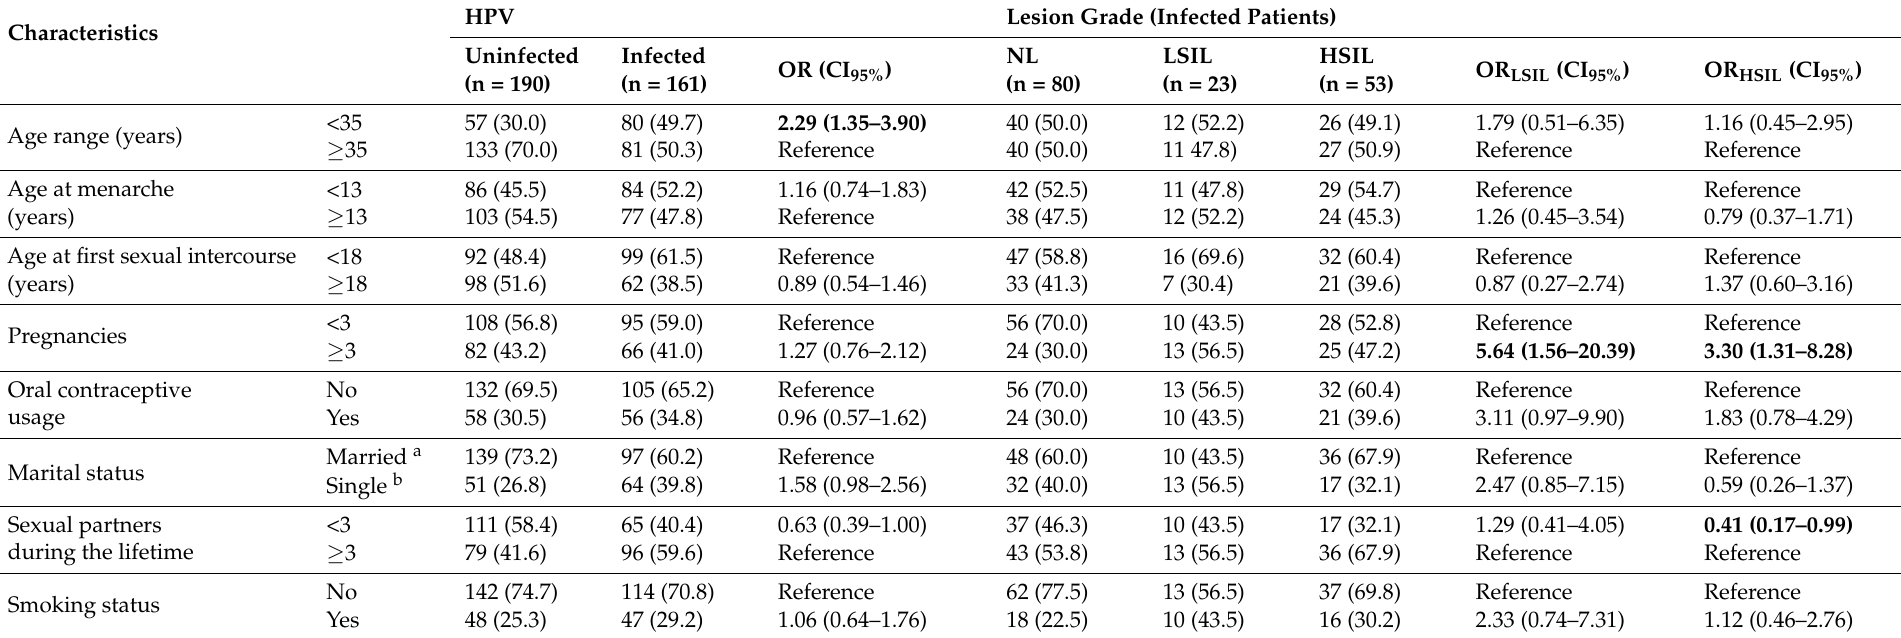
Table 1. Participant